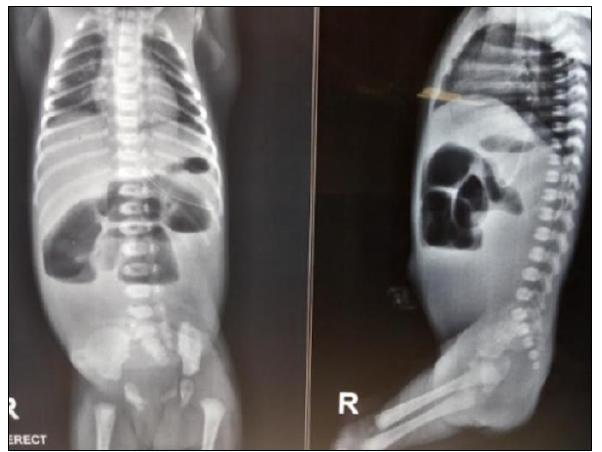
Figure 2: X-ray abdomen showing few dilated loops and air-fluid levels .